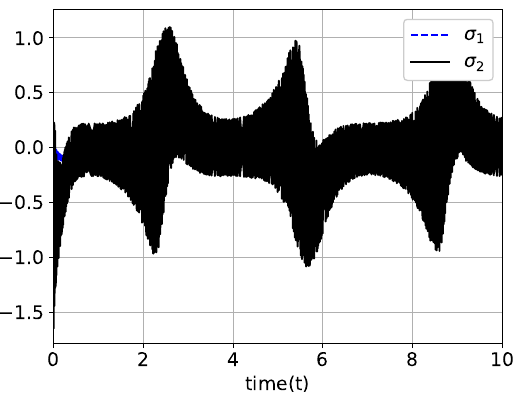
Figure 13. For HOSMD: trajectories of σ 1 and σ 2 .